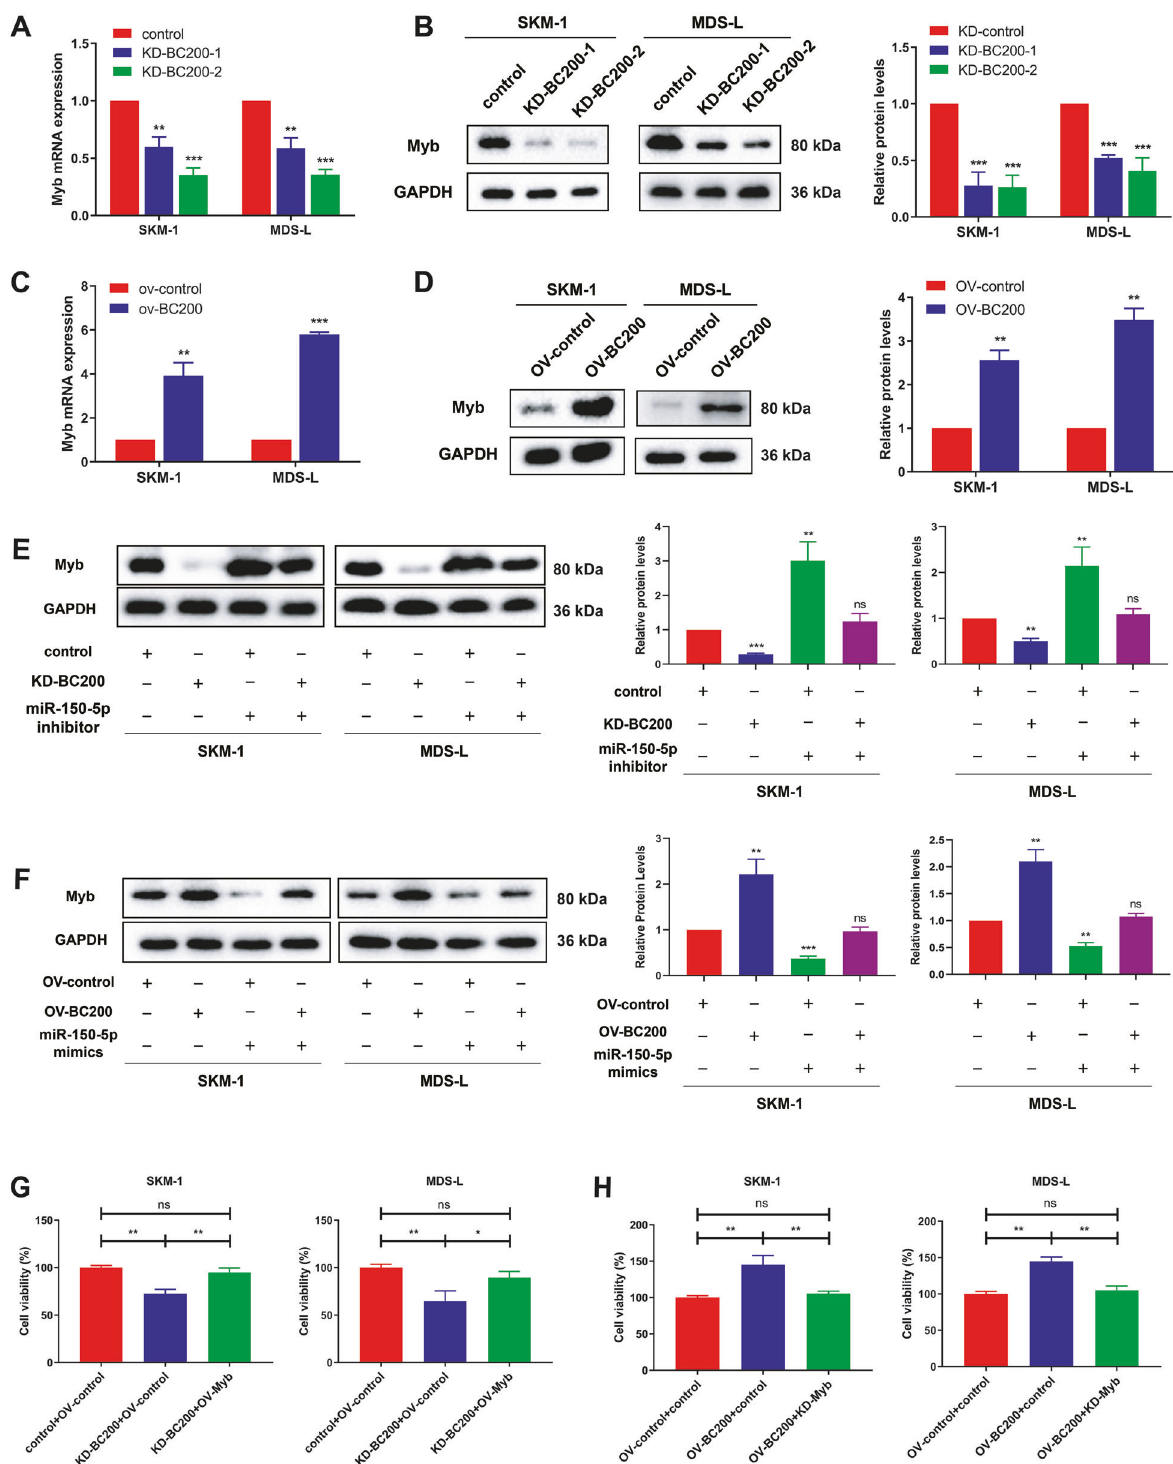
Fig. 4 BC200 promotes the proliferation of MDS cells via the miR-150-5p/MYB axis. A The mRNA levels of MYB were measured in sh-BC200 MDS cells. B The protein expression levels of MYB were measured in MDS cells transfected with two different BC200 shRNAs. C , D qRT-PCR and western blotting were used to measure the MYB mRNA and protein levels in SKM-1 and MDS-L cells transfected with BC200 plasmid (ov- BC200) for 48 h. E , F Western blot analysis of MYB in MDS cells cotransfected with miR-150-5p mimics and BC200 siRNA or miR-150-5p inhibitors and BC200 plasmid for 48 h. G CCK-8 assay indicated the effect of BC200 overexpression and MYB suppression on SKM-1 and MDS-L cell proliferation activity after 72 h. H CCK-8 assay indicated the effect of BC200 knockdown and MYB upregulation on SKM-1 and MDS-L cell proliferation activity after 72 h. * p < 0.05, ** p < 0.01, *** p < 0.001, ns, not signi fi cant.